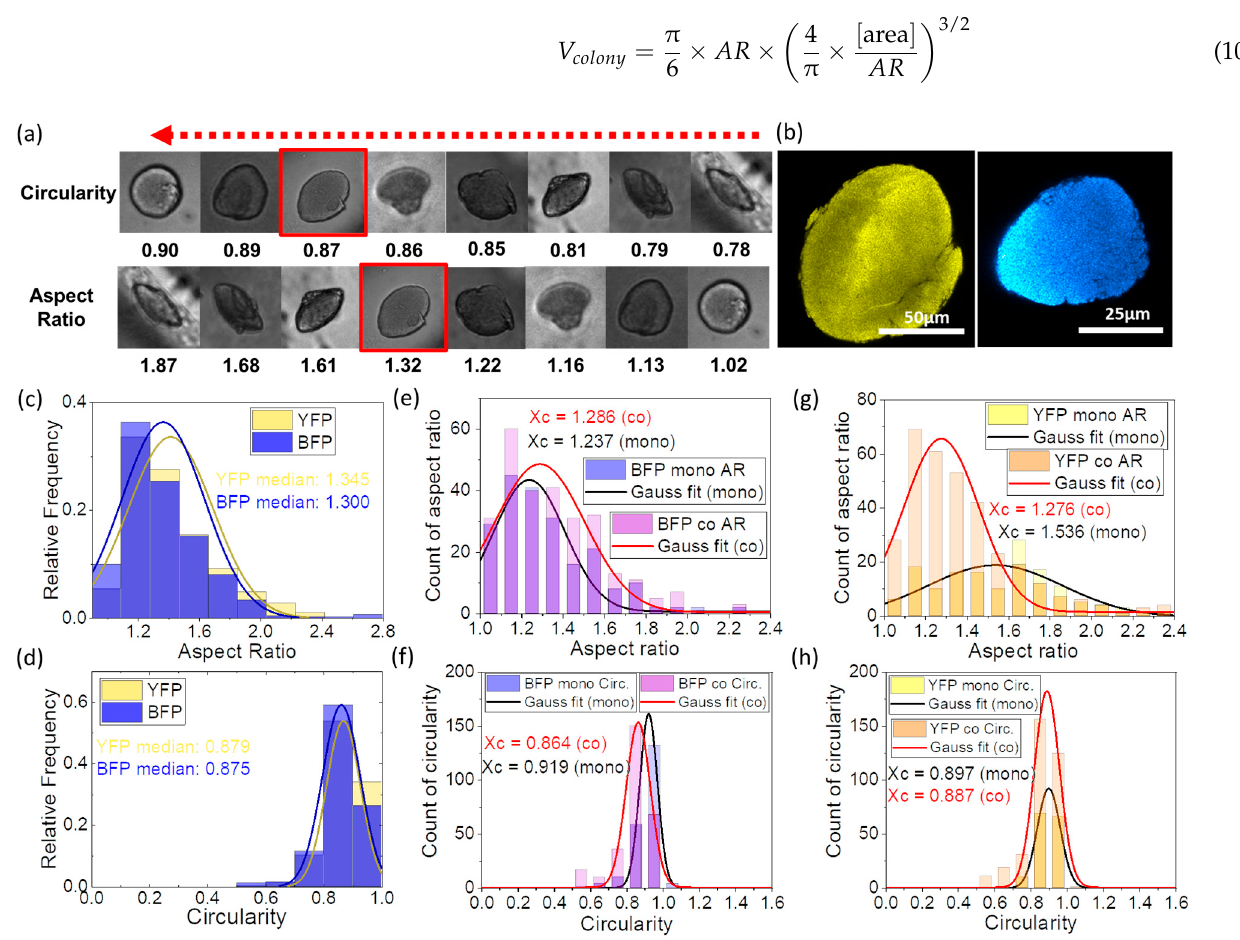
Figure 2. Typical morphology of bacterial colony inside agarose microbeads ( a ) Exemplary images of different bacterial colony morphologies formed in agarose microbeads categorized by shape indicators. Red boxes indicate the type of morphology that presents at the highest frequency after 12 h of incubation in co-culture. ( b ) Confocal microscopy images of E. coli YFP and E. coli BFP colonies grown in gel beads after 12 h of incubation in co-culture. ( c ) Aspect ratio and ( d ) circularity distribution of E. coli YFP and BFP colonies after 12 h of incubation. Comparison of ( e ) aspect ratio and ( f ) circularity of E. coli BFP monoculture and co-culture after incubating for more than 20 h. Comparison of ( g ) aspect ratio and ( h ) circularity of E. coli YFP monoculture and co-culture after incubating for more than 20